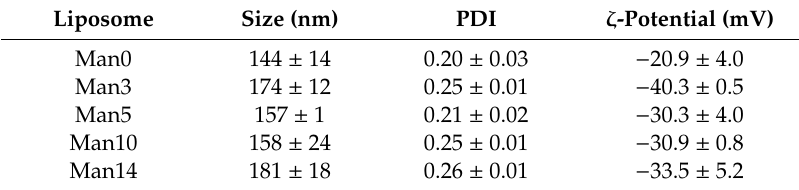
Table 1. Size, PDI and ζ -potential of liposomes modified with curdlan